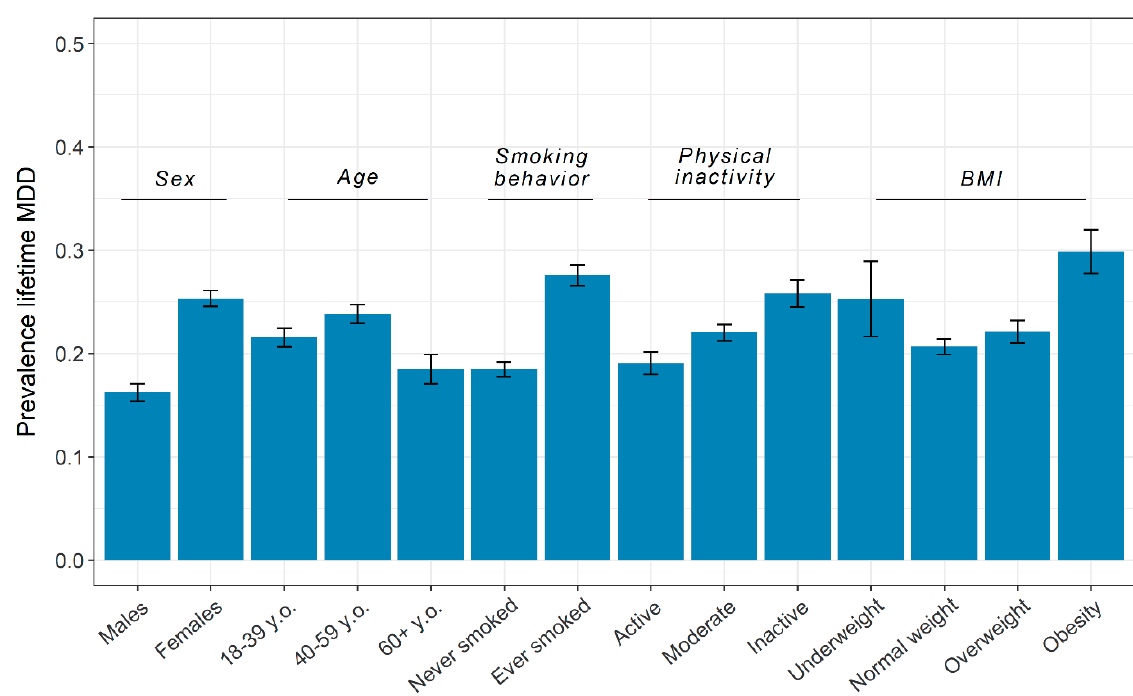
Figure 2. Prevalence of lifetime major depressive disorder across levels of demographic and lifestyle factors. MDD = major depressive disorder; BMI = body-mass index. Error bars reflect a 95% confidence interval.